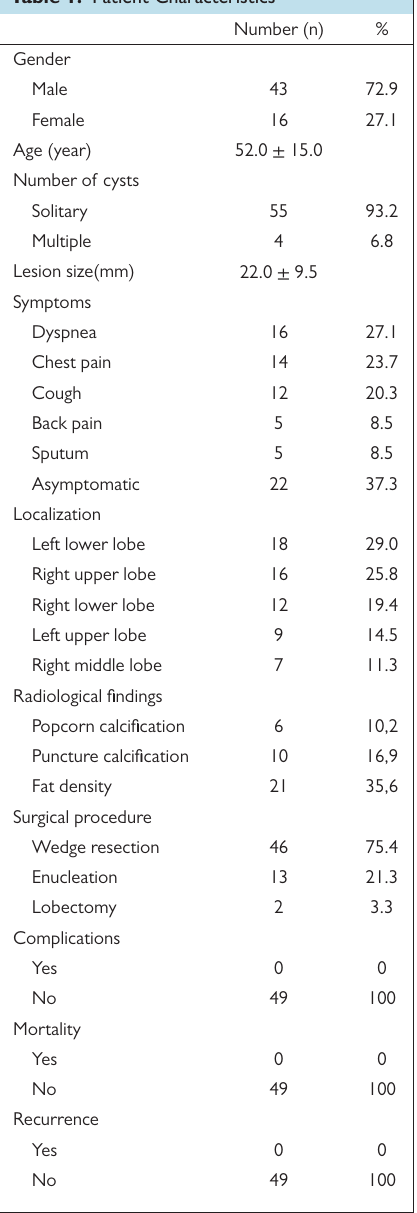
Figure 2. a-c. Chest x-ray radiography (a), chest CT scan in mediastinum window (b), and parenchymal window (c) sections show a solid mass with amorphous hyperdense calcified components in the right lower lobe superior segment in an 80-year-old male patient. CT, computed tomography. Table 1. Patient